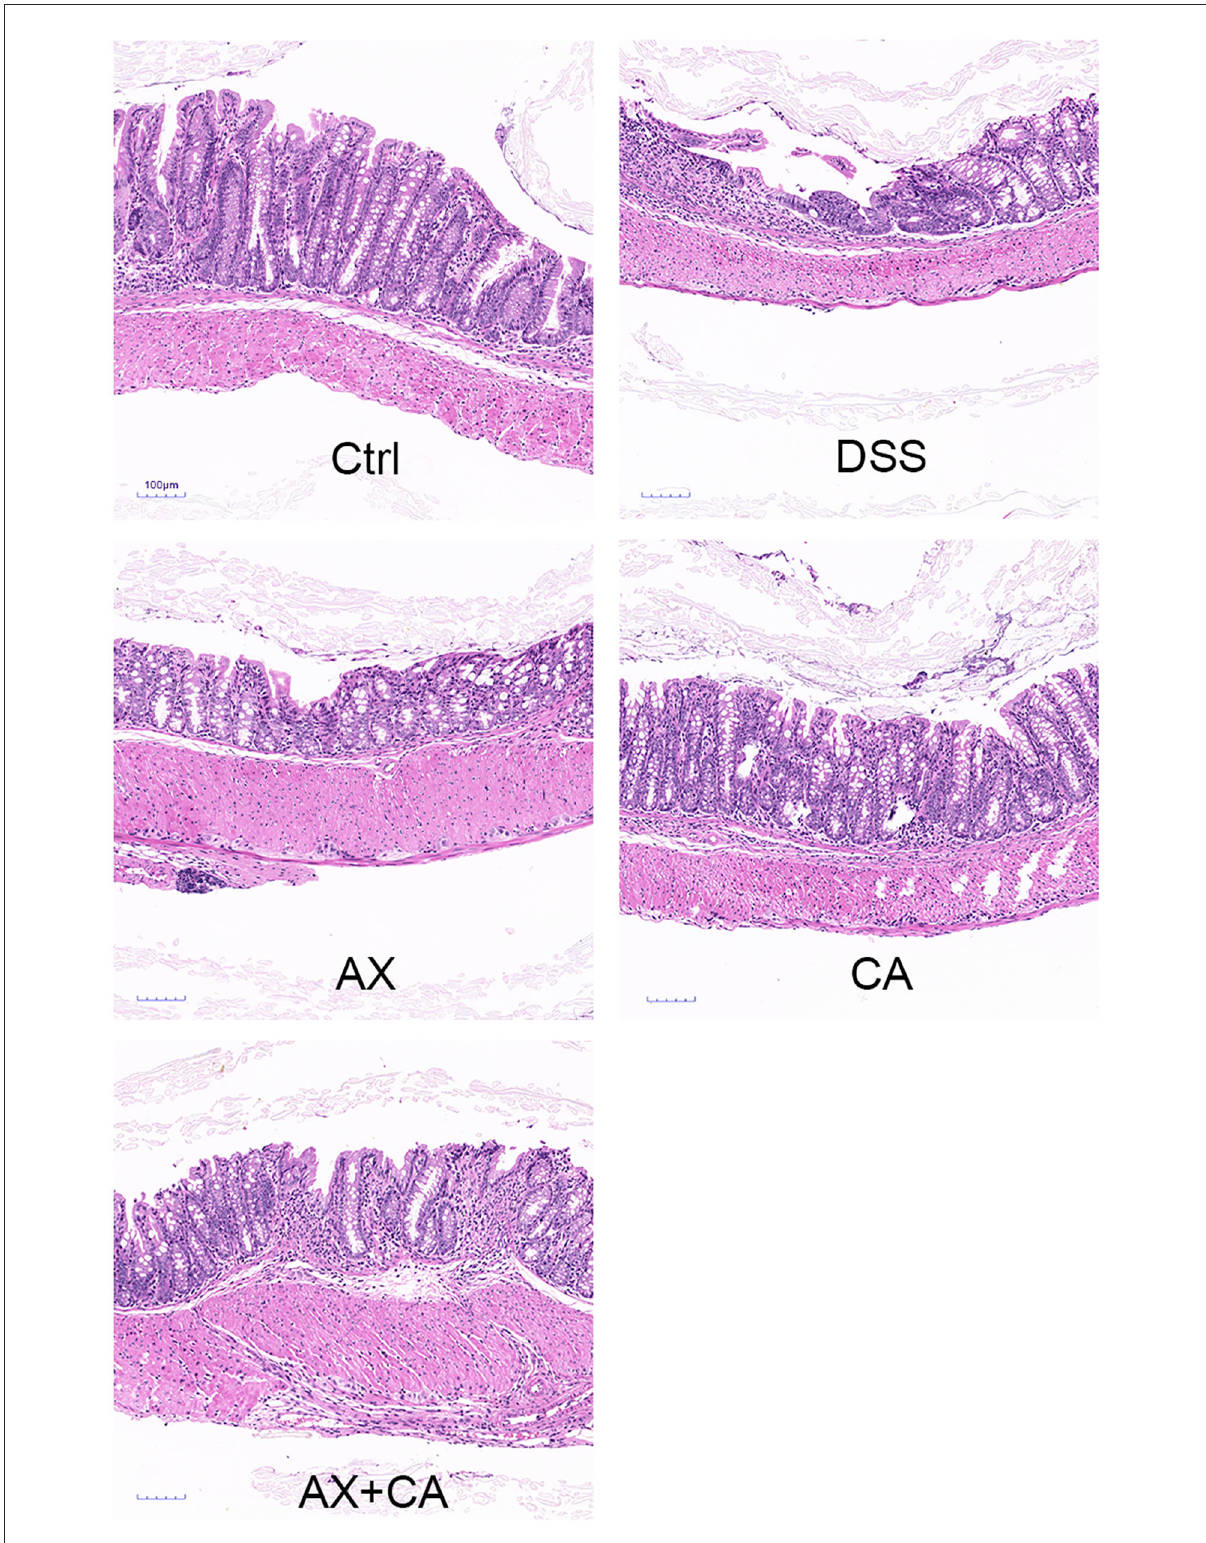
FIGURE3 Histological observations of colon tissue from mice in each